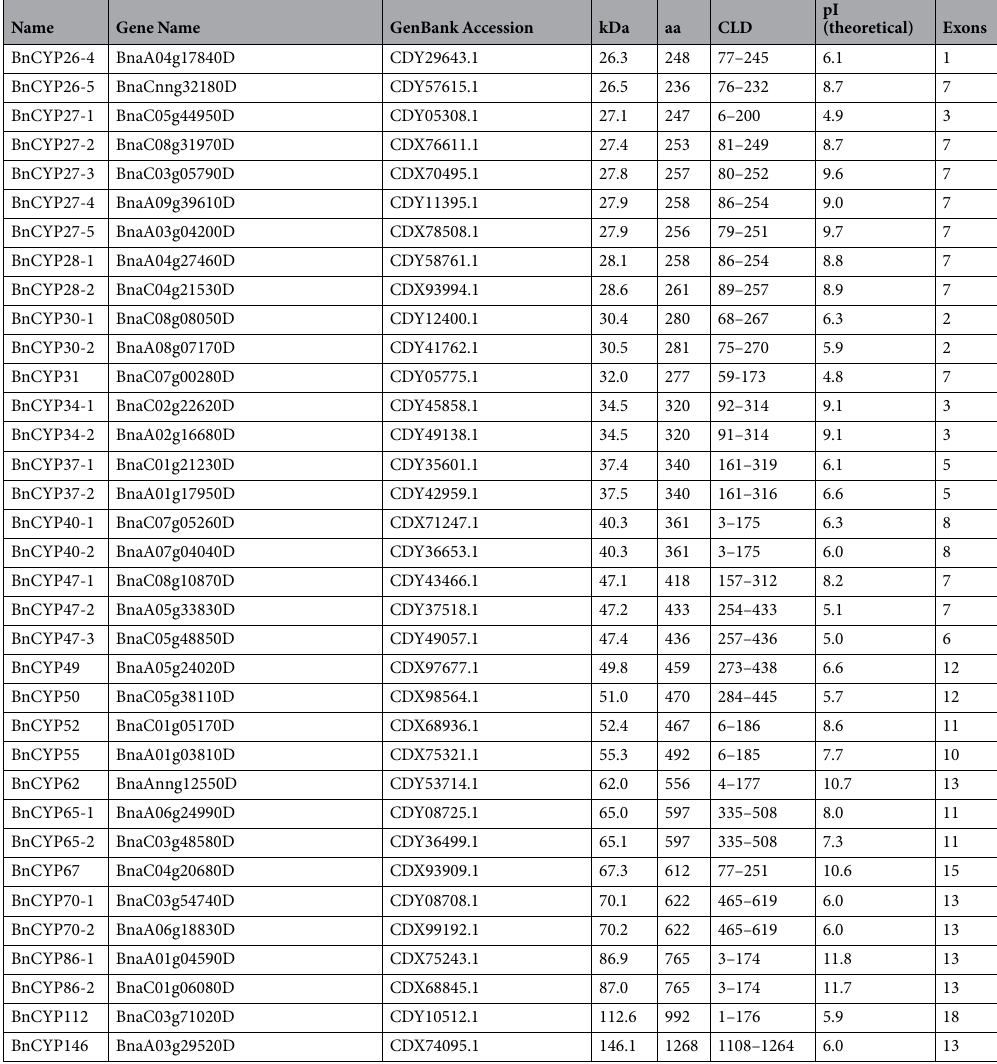
Table 1. Nomenclature, gene name, accessions, molecular weight, protein sequence length, information about aligned amino acids, theoretical isoelectric point, and predicted exons of the B. napus CYP